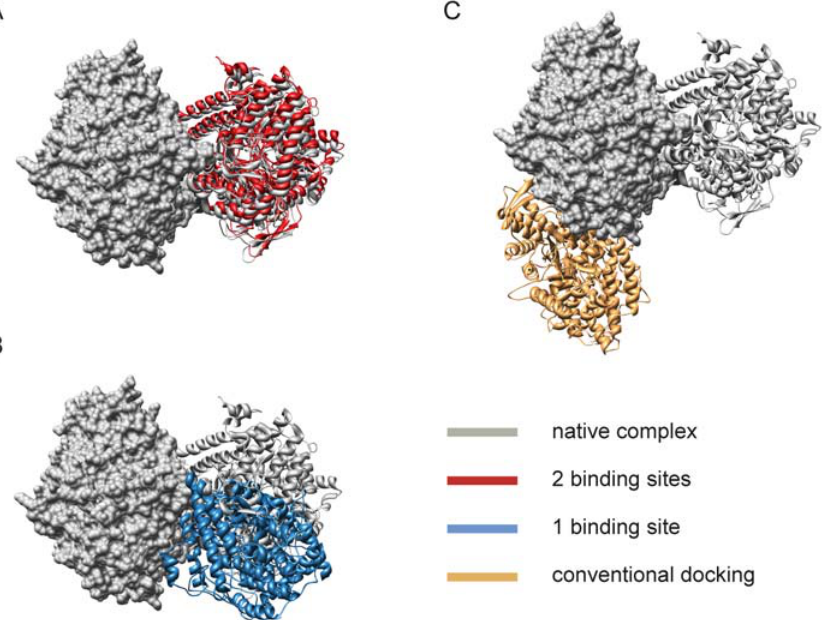
Figure 2. Examples of Predicted Protein Interface between Two Subunits for a Pyruvate Formate–Lyase Protein Complex from Our Benchmark Set Shown are the structures of the native complex (grey) together with the best-scoring models that were predicted by comparative patch analysis using binding site information for (A) both, or (B) just one of the interacting subunits, and (C) by conventional protein docking, where no binding site information is provided. The predicted and native structures are superposed using one of the two subunits, which is represented by its accessible surface. The remaining subunits of the predicted structures are shown in the ribbon representation colored red, blue, and orange, correspondingly. In both scenarios, comparative patch analysis was significantly more accurate than protein docking. Using both binding sites, comparative patch analysis accurately predicted the protein interaction interface, including the relative orientation of subunits. The accuracy of interface prediction by our approach using only one binding site was significantly reduced, while it was still able to predict the binding sites near their native locations. The conventional protein docking failed to accurately predict either the relative orientation of subunits or the locations of their binding